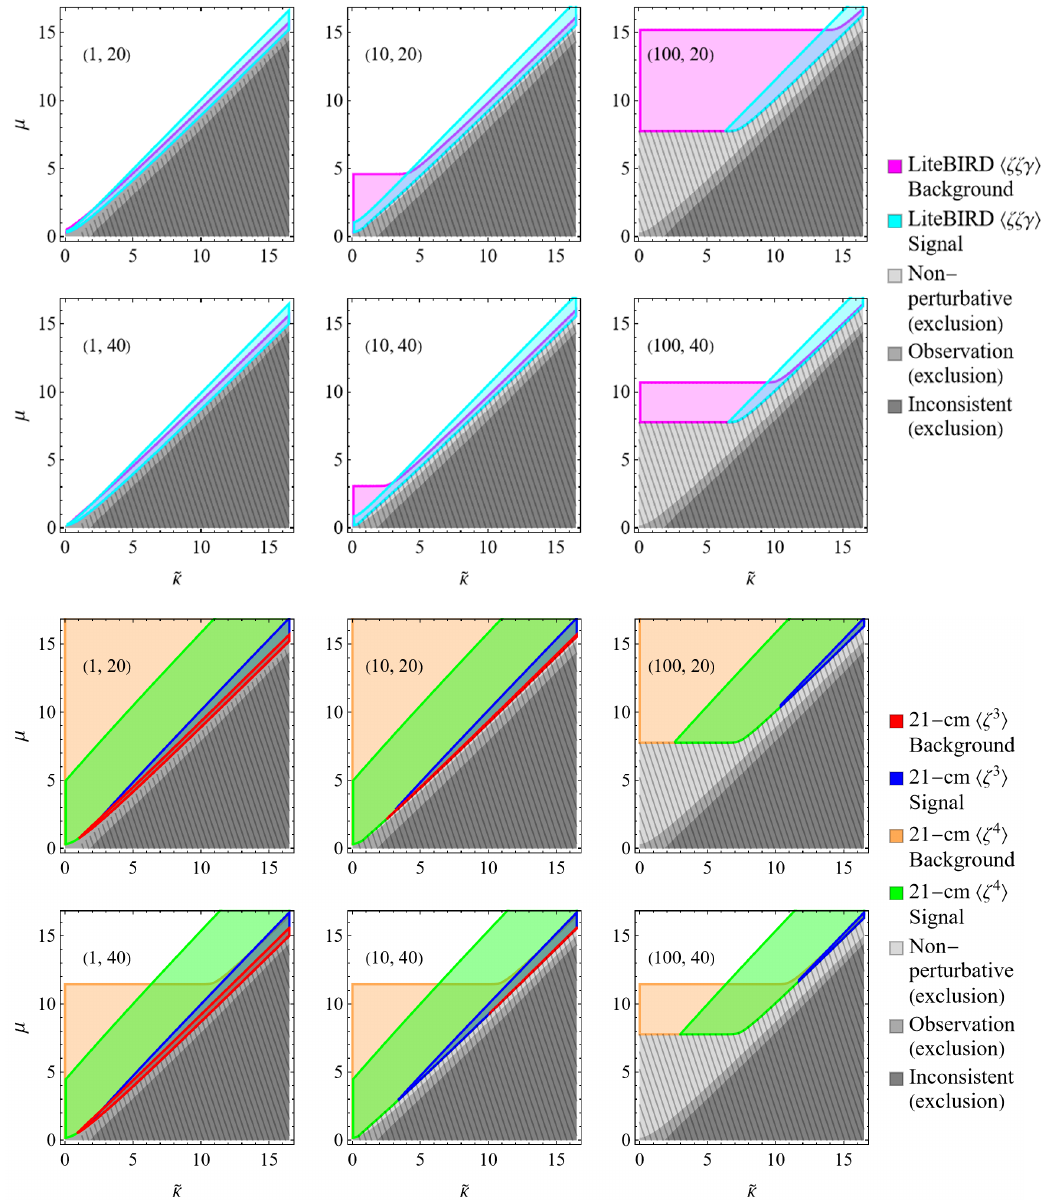
Figure 12 . The feasible parameter regions in our model for future observations. Upper panel: the parameter region viable for LiteBIRD detection of the mixed bispectrum. Lower panel: the parameter region viable for 21-cm interferometry detection of the scalar bispectrum (1-loop) and trispectrum (tree). The various colored regions give detectably large non-Gaussian backgrounds/CC signals for the corresponding experiment. The gray dashed regions are excluded by the imposed constraints. The horizontal axis is the dimensionless chemical potential ˜ κ = ˙ φ 0 / ( H Λ c ) and the p vertical axis is the dS-invariant mass of the spin-2 particle µ = m 2 /H 2 − 9 / 4 . Here we have assumed a tensor-to-scalar ratio r = 0 . 05 , a value consistent with the Planck bounds. The mixing coupling and the coupling to the inflaton are given in the parenthesizes as ( ρ, M/H ) . The LiteBIRD forecast sensitivity is taken as ∆ f NL,ζζγ = O (1) for both the background and CC signals [90], while the 21-cm interferometer sensitivity is taken to be ∆ f loc = O (10 − 4 ) , ∆ g loc = O (10) for the NL NL background shape and ∆ f clock = O (10 − 4 ) , g clock = O (100) for CC signals NL NL